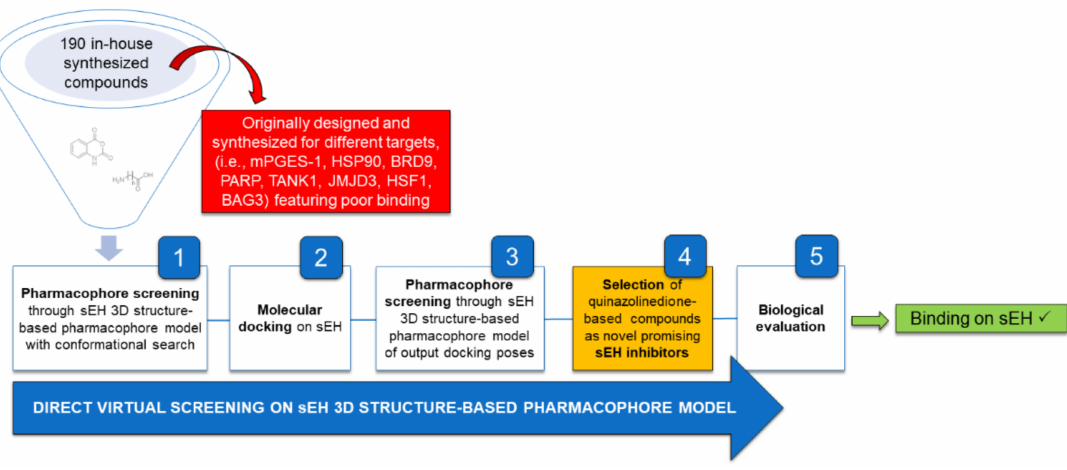
Figure 2. General workflow applied for the identification of quinazolinedione-based compounds as novel sEH